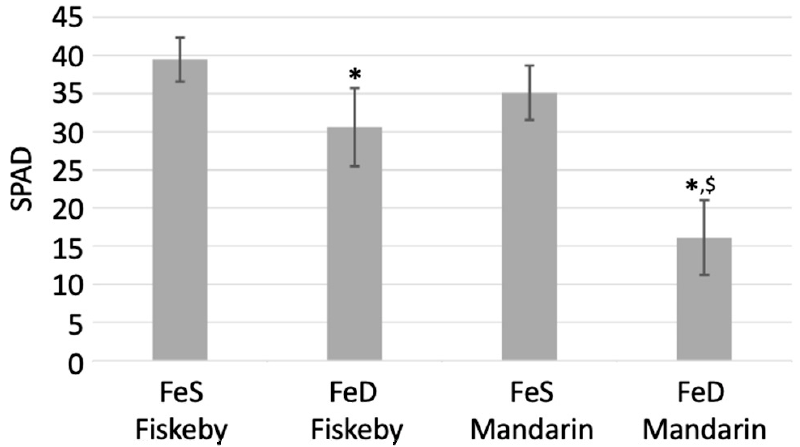
Figure 1. SPAD readings comparing Fiskeby III and Mandarin (Ottawa) grown for 14 days in iron sufficient (FeS) and iron-deficient (FeD) hydroponic conditions. Error bars are standard deviations calculated from six biological replicates. Astrisk (*) indicates a statistical difference between FeS and FeD within the same genotype. $ indicates a difference between genotypes of the same iron treatment (between Fiskeby III and Mandarin in FeD).